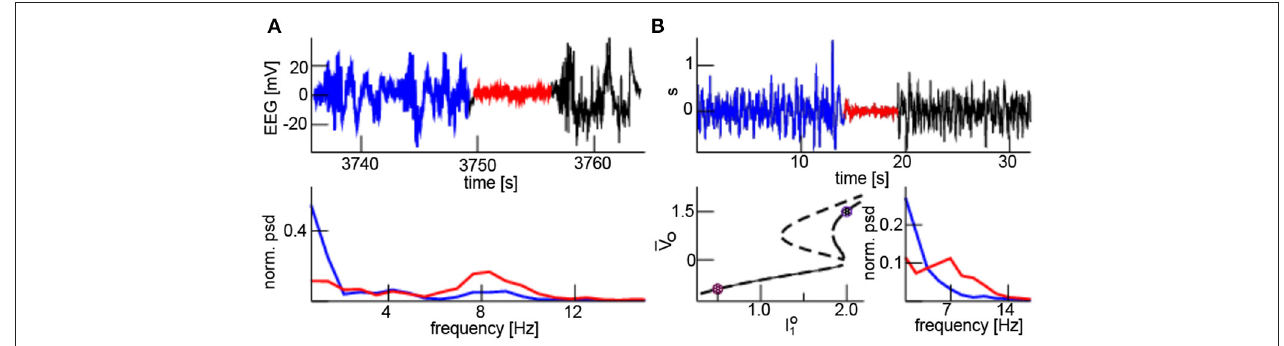
FIGURE 9 | Neural burst suppression. (A) Experimental EEG with burst broad-band high-amplitude activity (blue and black) and the low-amplitude narrow band suppression (red) phase (top panel); the power spectral density of the burst (blue) and suppression (red) phase (bottom panel). ( B , top) simulated EEG s ( t ) where F represents a band pass filter (upper panel); high input has I 0 I 0 0.5, A 0.0, D 1 0.3 for t [12.8s 19.2s]. ( B , bottom) The dashed and solid line represents the equilibria for low ( D 1 = = = ∈ ; levels, respectively; circles mark the high and low input with corresponding equilibrium (left). The normalized power spectral density of the burst (blue) and suppression (red) phase shows broad-band and phase-coherent states, respectively (right). In the model simulations, other parameters are taken from Figure 4 and time is re-scaled by t 0.04 t →